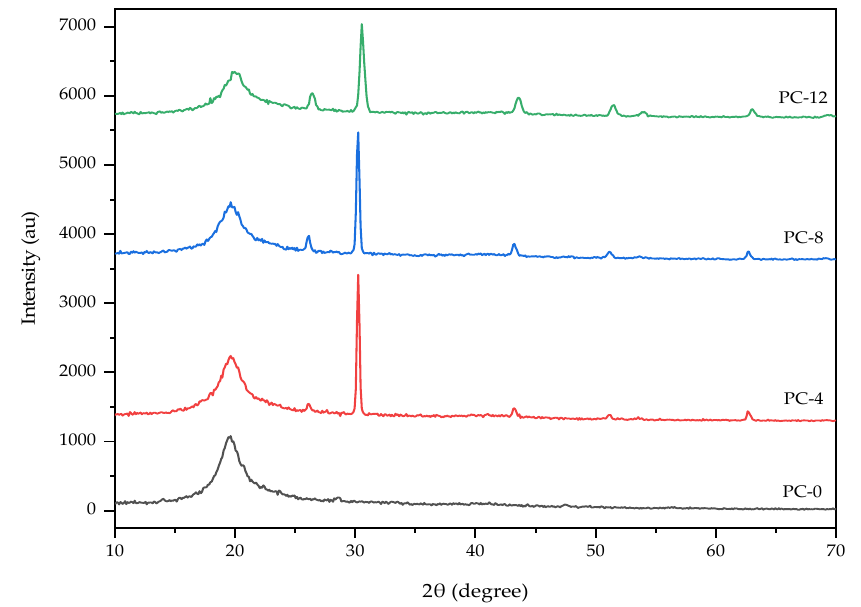
Figure 1. The pattern of XRD for pure PVA and PVA/PbSNCPs.